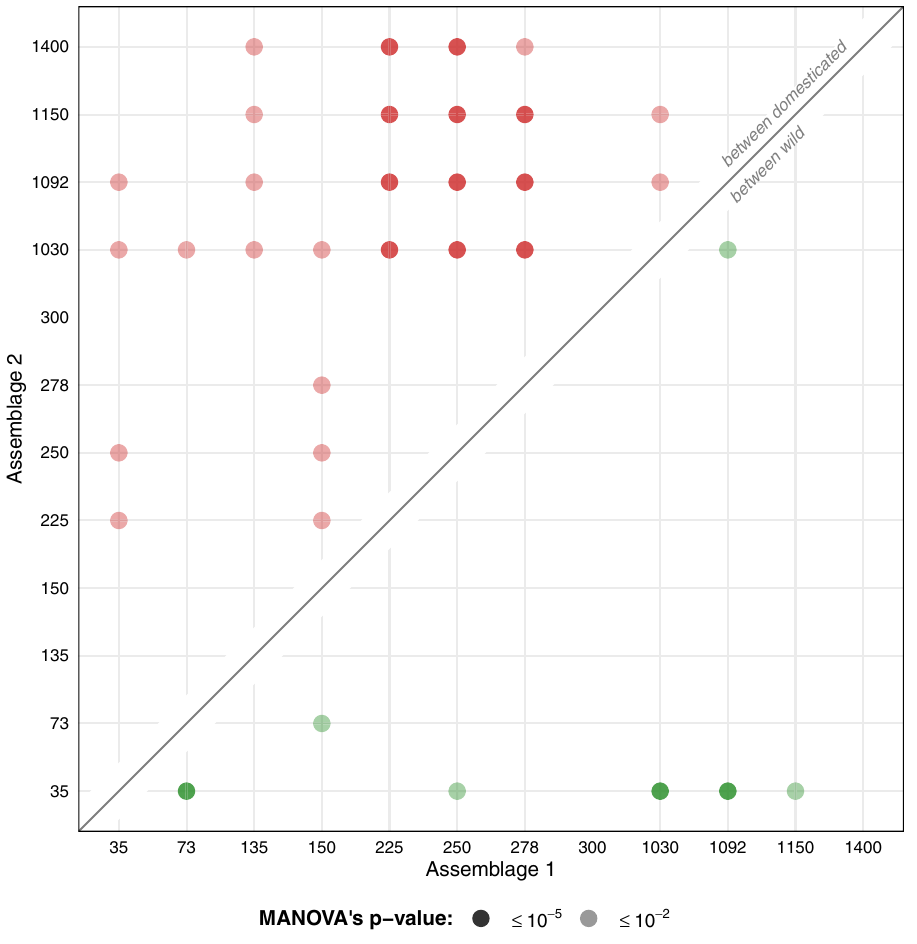
Figure 4. Pairwise multivariate analyses of variances. Differences were tested using the first two principal components showed in Fig. 3, between pairs of assemblages and separately for sets of pips identified as of domesticated and wild types. 300-Reims VieuxPort was removed from pairwise comparisons due to very small sample size (N =